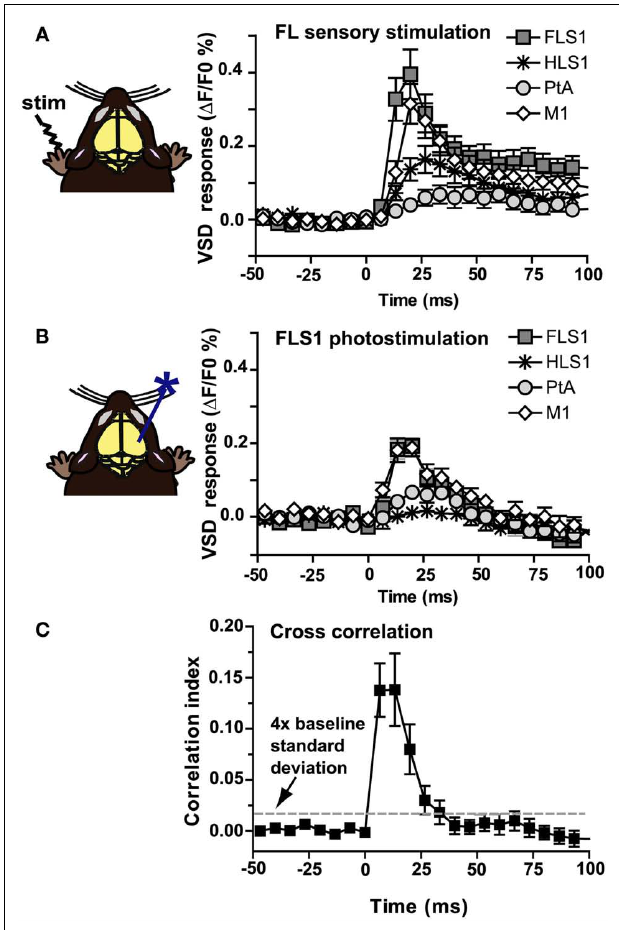
FIGURE 3 |Temporal correlation between sensory-evokedVSD responses and ChR2-evokedVSD responses. (A) VSD responses from selected regions in the contralateral hemisphere after electrical stimulation to the forelimb ( n = 10 mice). (B) VSD responses from selected regions in the contralateral hemisphere after photostimulation of FLS1 ( n = 10 mice). (C) A Pearson correlation coefficient between sensory and ChR2-evoked responses was computed ( n = 10 mice) for all pixels and plotted in a frame by frame manner to determine correlation. Note the high correlation index during the first 25ms after stimulation, where the correlation index is greater than four times the SD of baseline (dashed